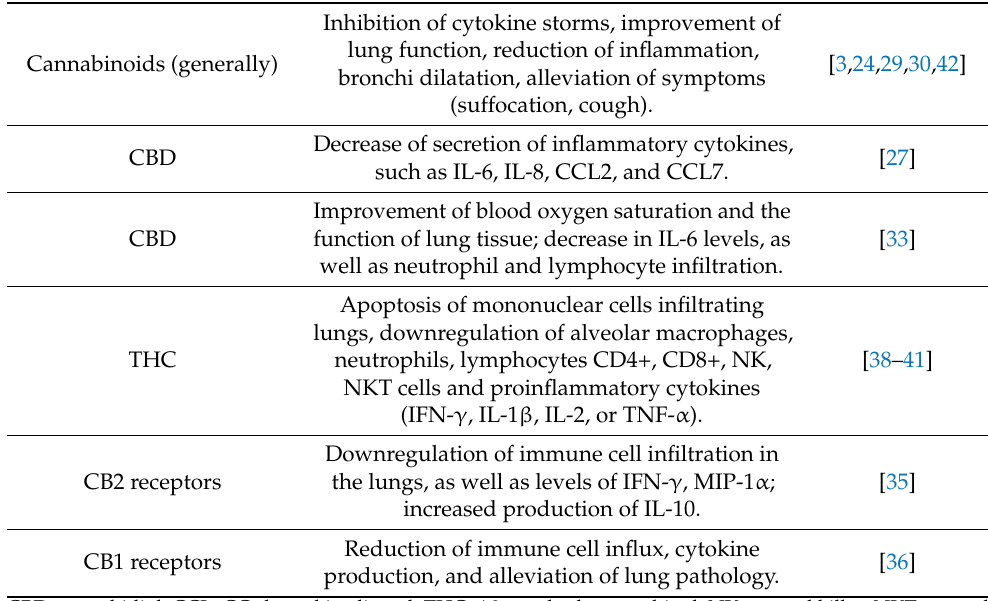
Table 2. The multifaceted effects of phytocannabinoids and the endocannabinoid system on the respiratory